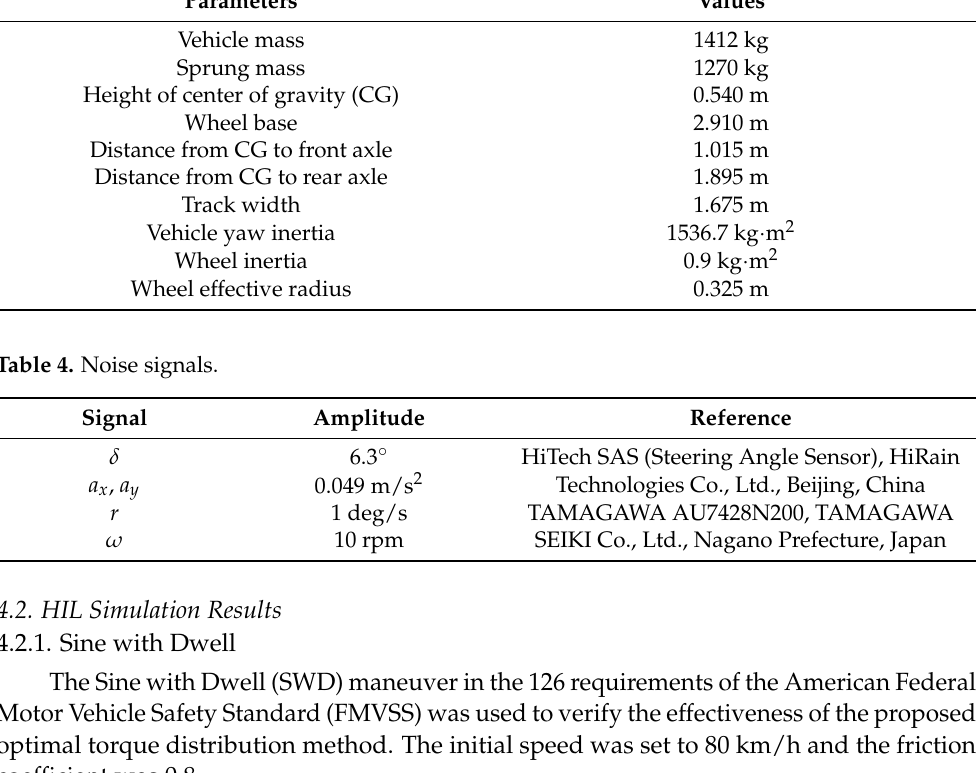
Table 3. Vehicle parameters.